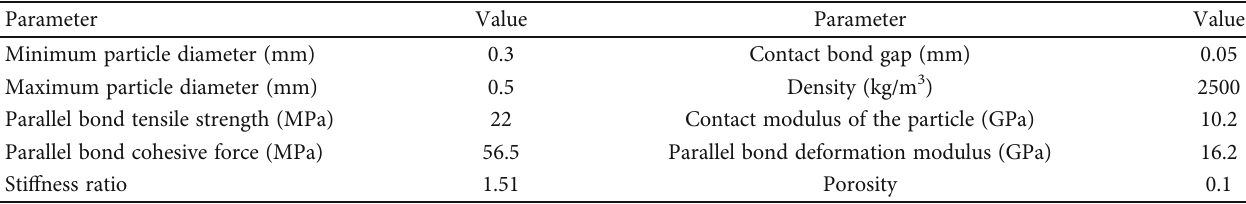
Table 1: Microcosmic-mechanical parameters of the model.